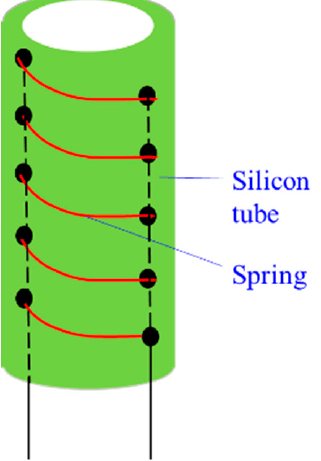
Figure 16. The soft tube-spring CCR [109].